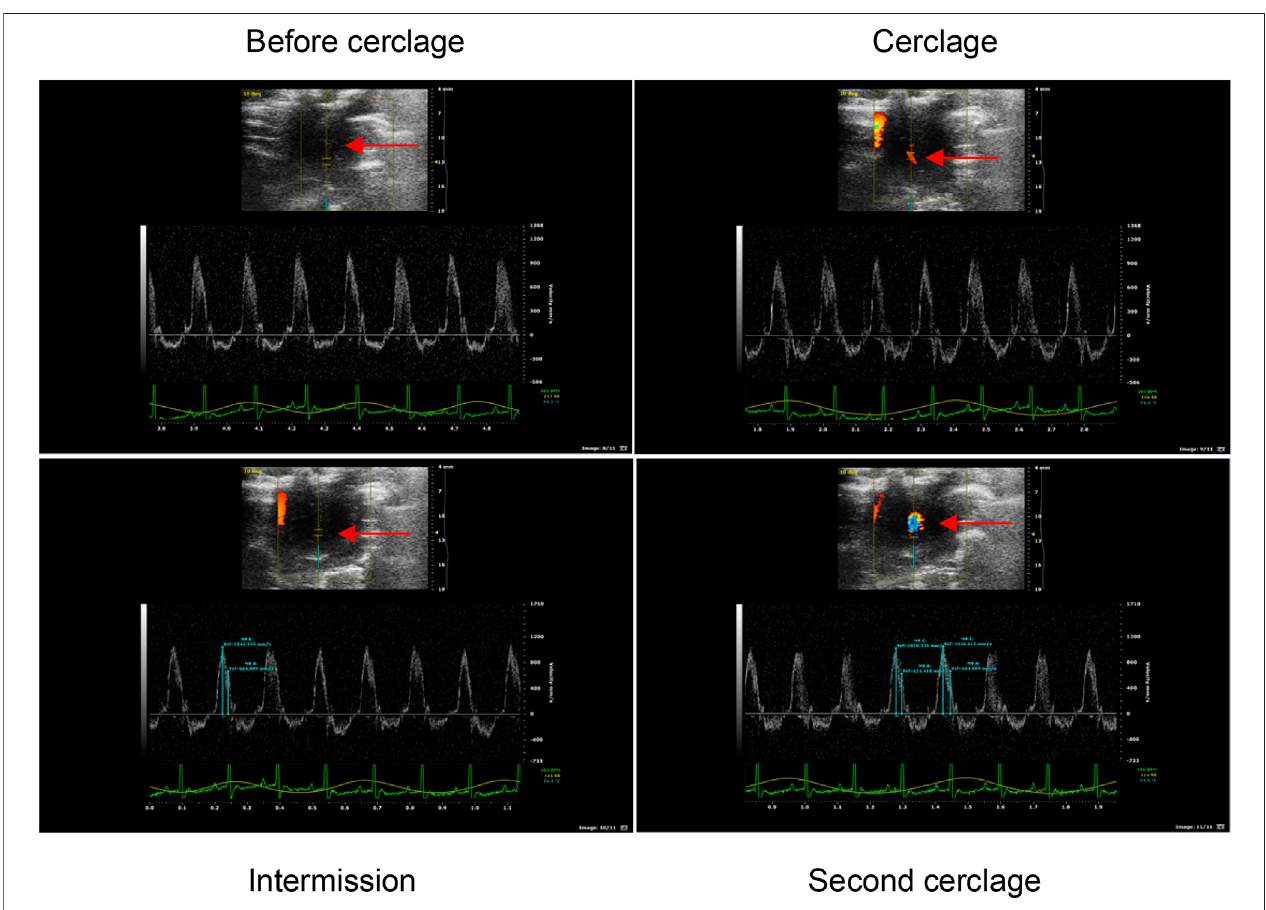
FIGURE 1 | Ultrasonic detection of blood fl ow limitation in the right lower limb of BFRT group rats. The arrow marks the location of blood fl ow limitation of the right lower limb of BFRT group rats, and the red and blue bright spot at the mark is effective ischemia.